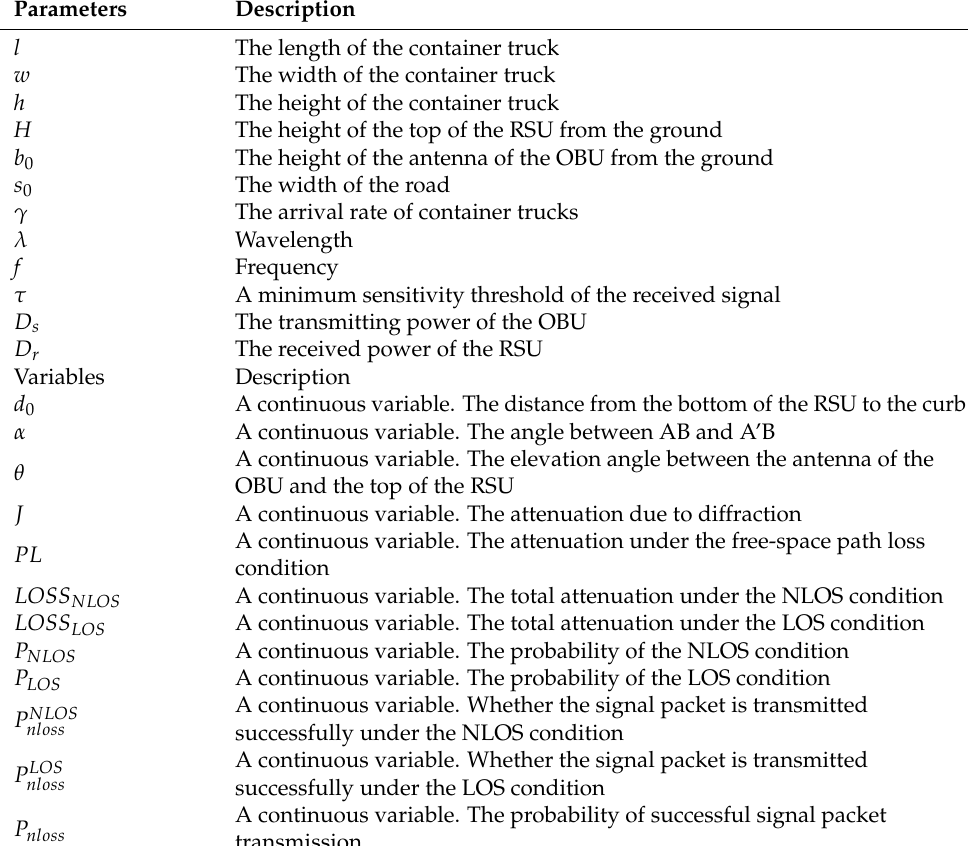
Figure 1. Model of traffic flow under the fading channel condition. Table 1. Parameters and variables used in the problem statement.